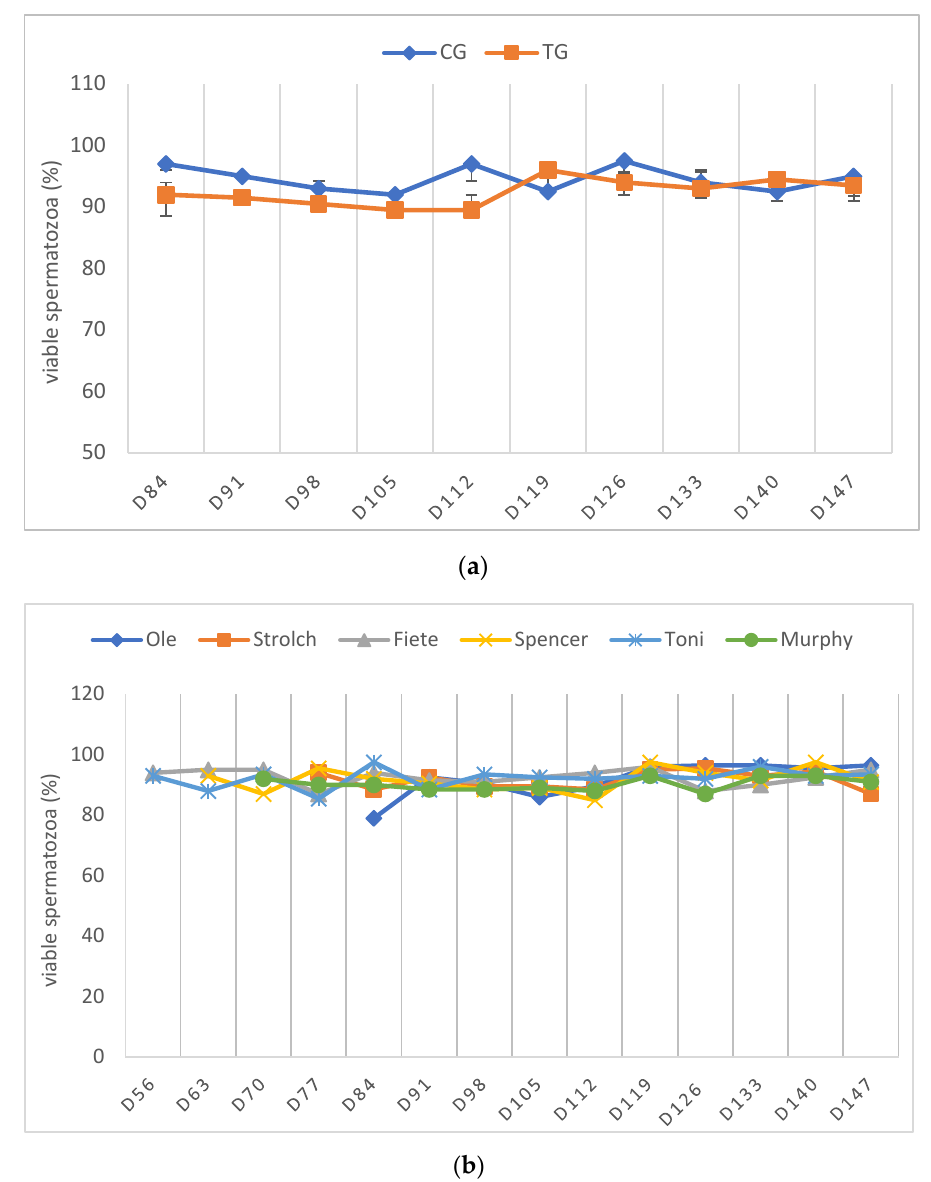
Figure 6. ( a ) Percentage of viable sperm given as median (Q1, Q3) over time of animals treated with a 4.7 mg deslorelin implant (TG, n = 5, excluding Murphy) and saline-treated control animals (CG, n = 3). ( b ) Percentage of viable sperm given as individual courses of animals treated with a 4.7 mg deslorelin implant (TG, n = 6) over time.